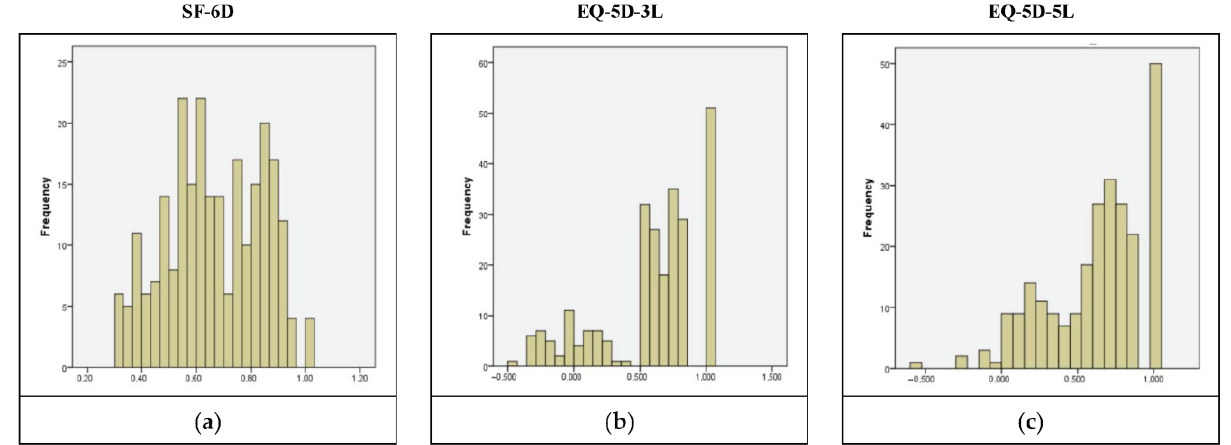
Figure 1. Distribution of SF-6D ( a ), EQ-5D-3L ( b ), and EQ-5D-5L ( c ) utility scores.